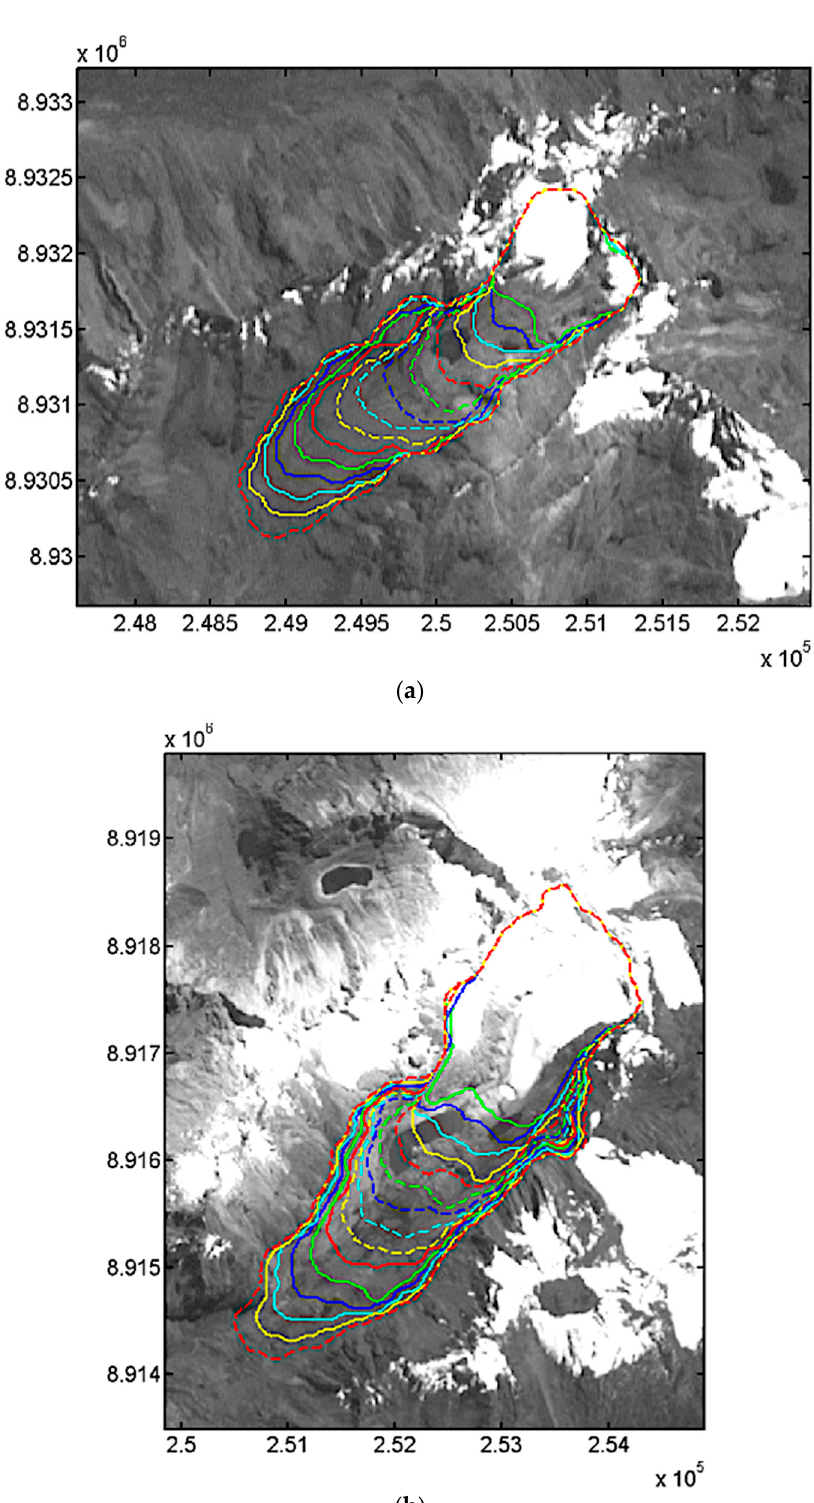
Figure 8. The paleoglacier reconstruction of the LIA maximum (1850 AD). The series of reconstructed paleoglacier boundaries in 10-year intervals for ( a ) YAN, ( b ) QUE.